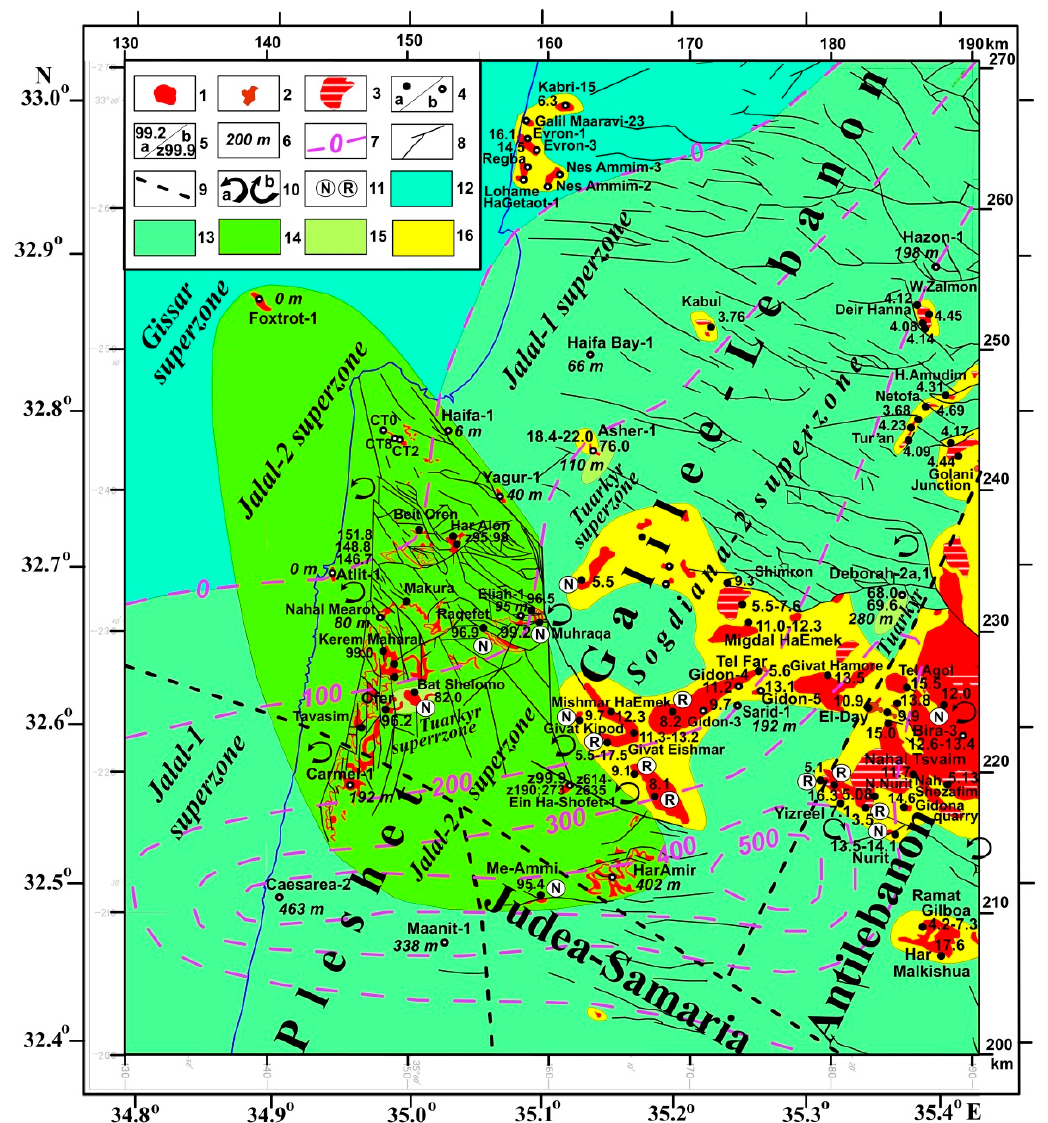
Figure 4. Geodynamic-paleomagnetic map of the Mt. Carmel—Galilee region (northern Israel). The following main works were used for this map construction: [10,32–38,75,77–92]. (1) Cretaceous- Miocene basalts, (2) Miocene gabbroid intrusive, (3) Pliocene Cover basalts, (4) outcrops: (a) and boreholes, (b) with the Mesozoic-Cenozoic magmatic complexes, (5) radiometric age of magmatic rocks and minerals from K-Ar, Ar-Ar methods (a) and zircon geochronology (b), (6) thickness of the Lower Cretaceous traps (in m), (7) isolines of the Lower Cretaceous traps thicknesses (in m), (8) faults, (9) boundaries of terranes, (10) counterclockwise (a), and clockwise (b) rotation derived from the tectonic and paleomagnetic data, (11) data of paleomagnetic measurements of magmatic rocks with the normal ( N ) and reverse ( R ) polarities, (12–15) paleomagnetic superzones: (12) Gissar, (13) Jalal-1, (14) Jalal-2, (15) Tuarkyr, (16)